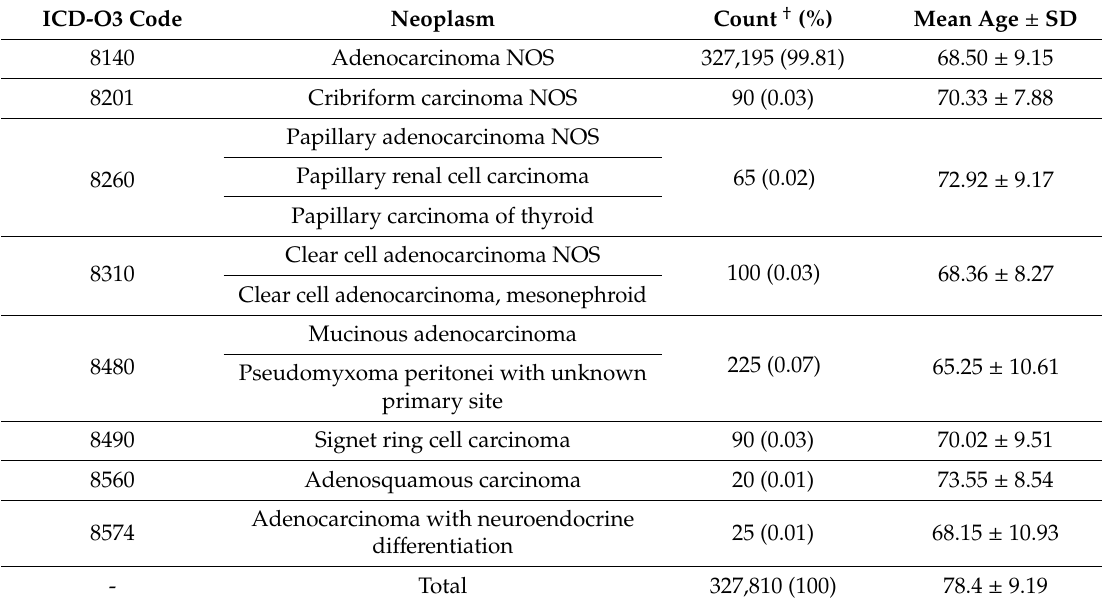
Table 1. List of prostate malignancies included in this study along with their corresponding ICD-O-3 codes, the number of cases reported in Canada between the years 1992 and 2010, and the mean age at the time of diagnosis. The same ICD-O3 code is used to represent more than one prostate cancer